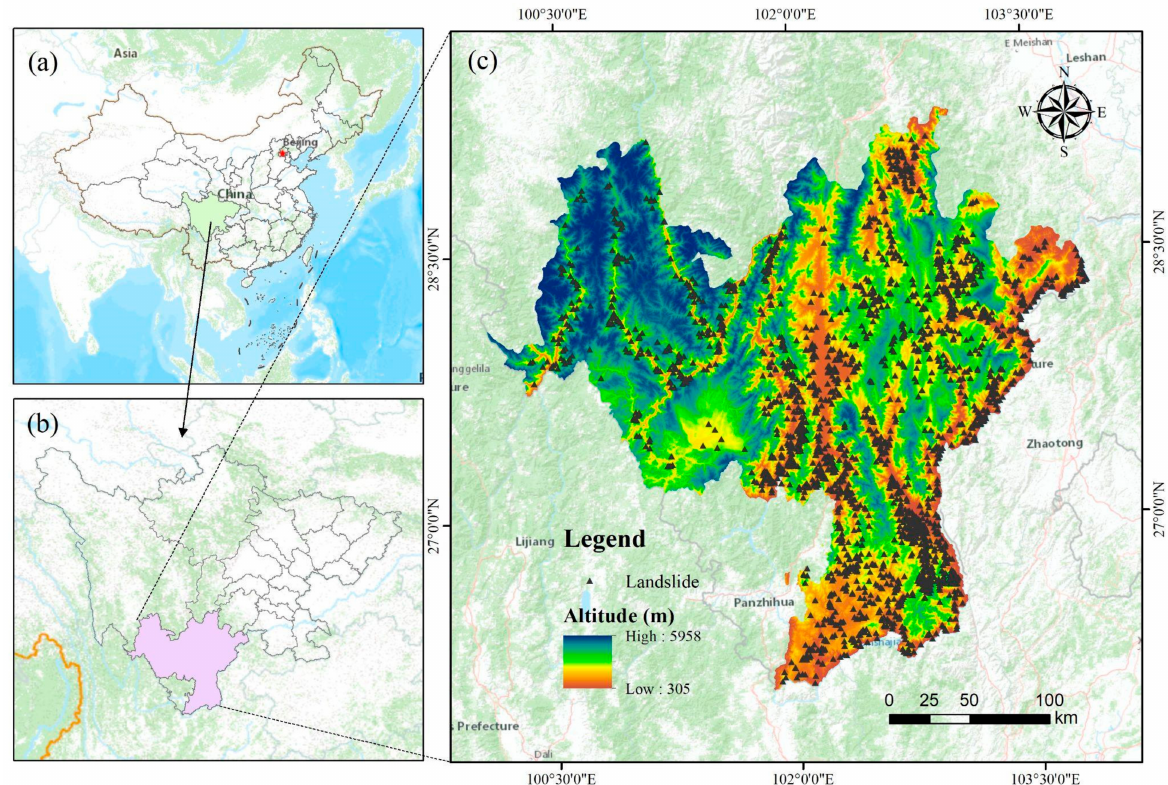
Figure 1. The study area: ( a ) China; ( b ) Sichuan Province; ( c ) Liangshan Prefecture. The topographical and geological structures of this region are very complex. Topo- graphically, this region is located in the northeastern margin of the Hengduan Mountains in southwestern Sichuan and bounded between the Sichuan Basin and the central plateau of Yunnan Province. The landform is dominated by plateaus and mountains. The terrain decreases from northwest to southeast, with elevations ranging from 305 to 5958 m